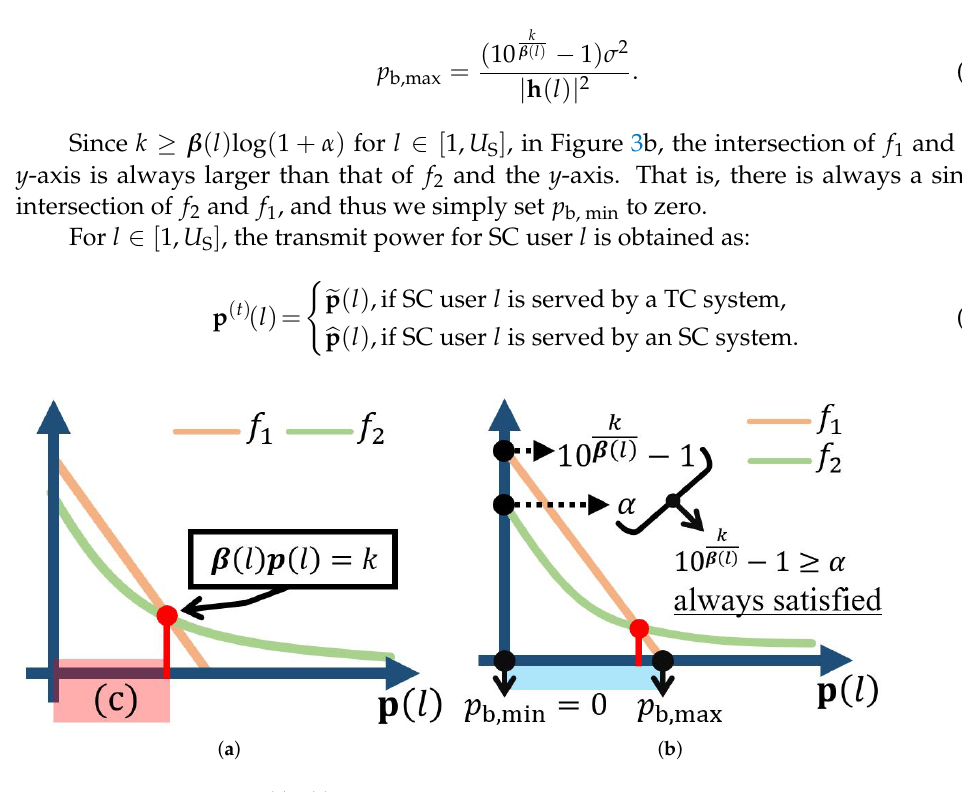
Figure 3. Examples for β ( l ) p ( l ) = k . ( a ) example of the intersection of f 1 and f 2 ( b ) the maximum and minimum initial values of the bisection method for p ( l ) .